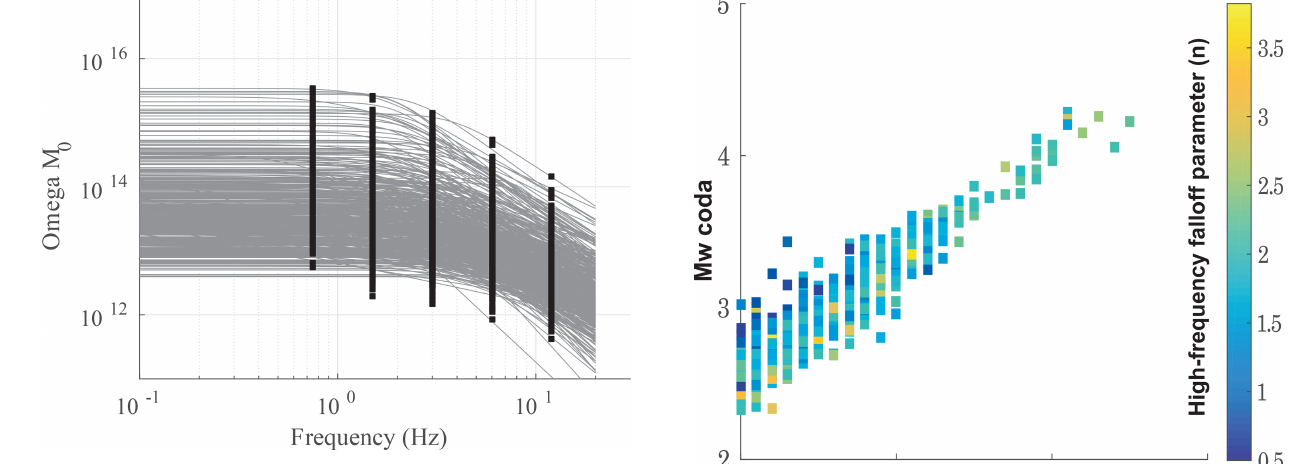
local earthquakes in this region: